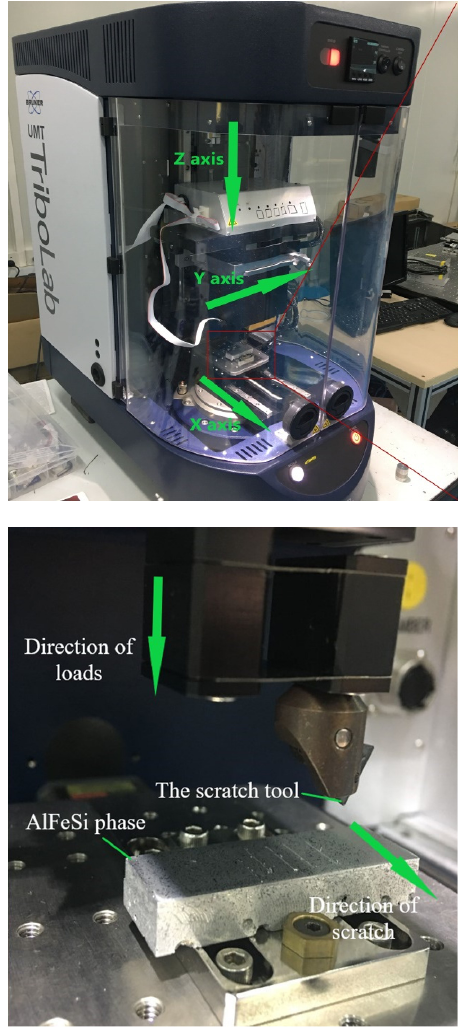
Figure 12. The scratch experiment of AlFeSi phase.